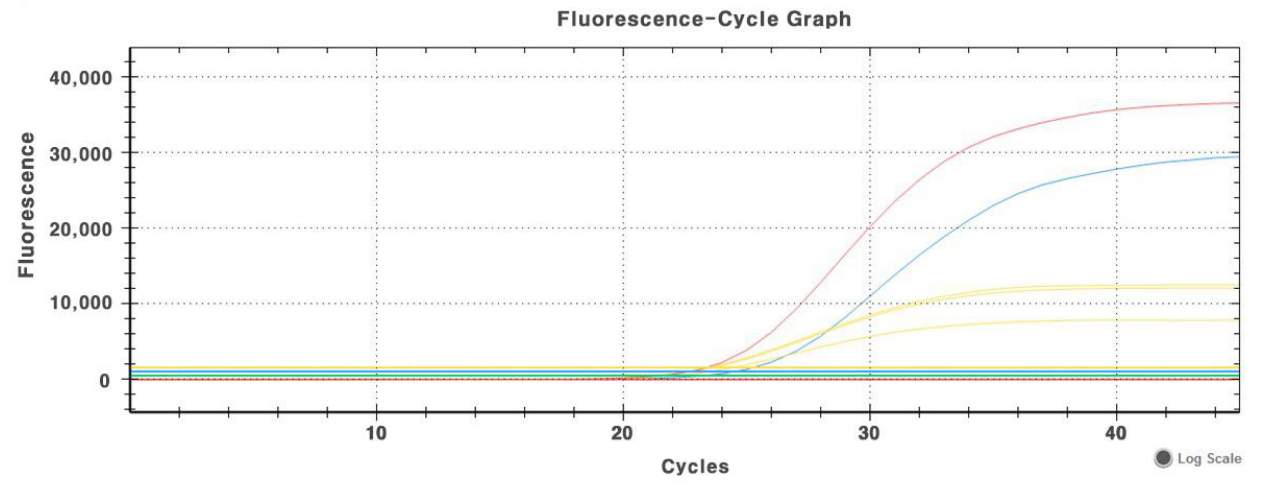
a For household and sex, p -value determined by two-sided Fisher’s exact test. Household COVID+ defined as one or more members of a household with a confirmed positive COVID-19 test. All the information was not available for all the animals. There is no significantly differences among risk factors (Households, Animal Shelters, Sex and Age).